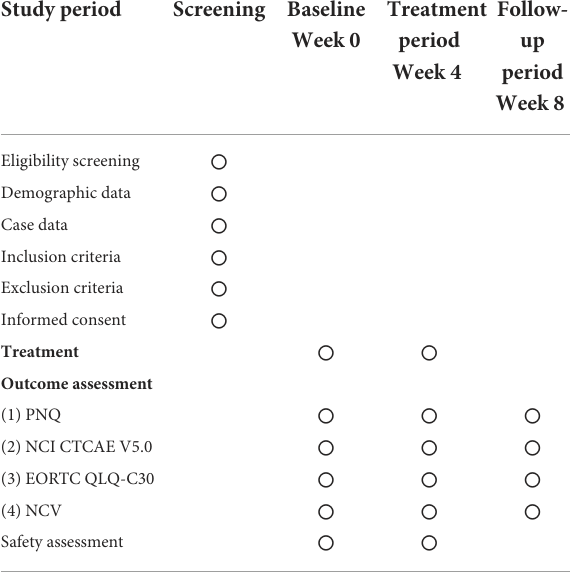
Screening Baseline